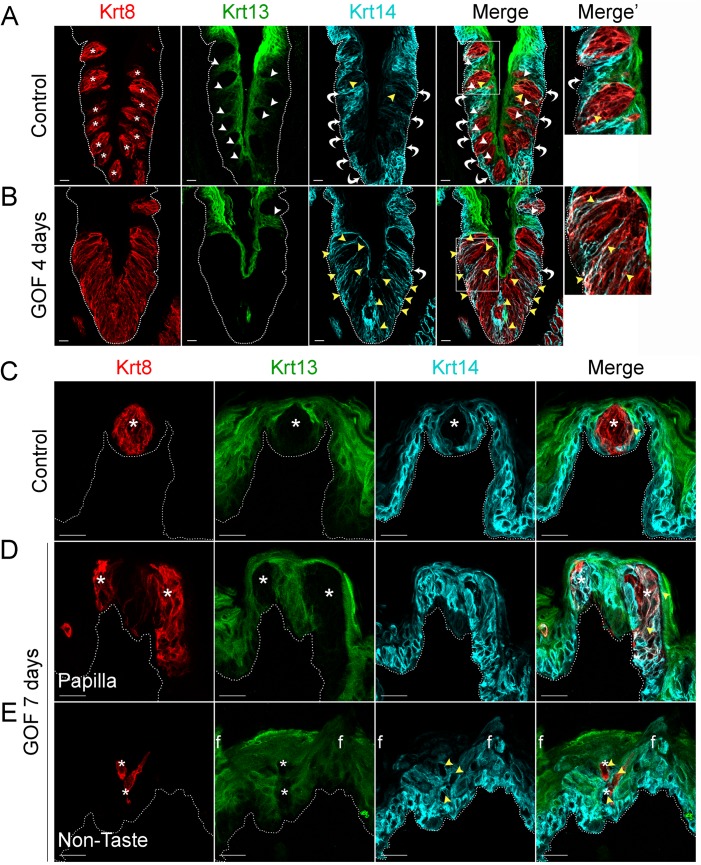
Stabilized β-catenin depletes progenitors (Krt14+) and causes lingual epithelial cells to differentiate as taste cells (Krt8+) at the expense of non-taste cells (Krt13+).Mutant (Krt5rtTA;tetOCre;Ctnnb1(Ex3)fl/+) and control mice were fed doxycycline-supplemented chow for 4 or 7 days, their tongues harvested, and CVP and anterior tongue sections immunostained for markers of taste cells (Krt8), non-taste squamous epithelium (Krt13), and basal progenitor cells (Krt14). A. In the CVP of control mice, distinct Krt8+ taste buds (red, * indicates a taste bud) are interspersed in the apical epithelium with Krt13+ postmitotic squamous keratinocytes (green, white arrowheads). Ovoid Krt14+ progenitor cells (cyan) are restricted to the basal epithelium (white bent arrows), although occasional elongate Krt8+ cells are also dimly Krt14+ (yellow arrowheads). B. In the CVP of Krt5rtTA;tetOCre;Ctnnb(Ex3)fl/+ mice, Krt8+ cells are greatly expanded, and Krt13+ cells typically found between taste buds are absent (compare white arrowheads in A and B). Ovoid Krt14+ basal cells are also slightly reduced (compare white arrows in A and B, and white arrows in A and B Merge’, while persistent Krt14 staining in the Krt8+ taste field is dramatically increased compared to controls (A and B, yellow arrowheads). C. In the anterior tongue of controls, each FFP houses a single Krt8+ taste bud (red, * indicates a taste bud) surrounded by Krt13+ squamous epithelium (green), while basal cells adjacent to taste buds and throughout the FFP epithelium are Krt14+ (cyan). D. In mutants with stabilized β-catenin, ectopic Krt8+ cell clusters occur in FFP (red), which are devoid of Krt13 (green; white asterisks), while many are Krt14+ (cyan, yellow arrowheads, white signal in merged panel). E. Krt8+ cells (red) are detected ectopically, interspersed among filiform papillae (“f”) of the non-taste lingual epithelium. These Krt8+ cells are Krt13-negative, and frequently Krt14+. Stack images are representative samples from 3 control and 3 mutant mice. Dotted line delineates the basement membrane. Scale bars = 20 μm.